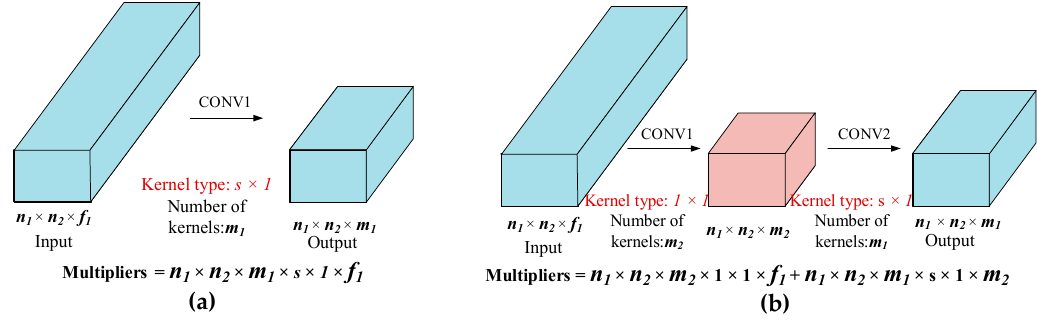
Figure 4. Convolution operation: ( a ) Based on HI; ( b ) using 1 × 1 convolution.